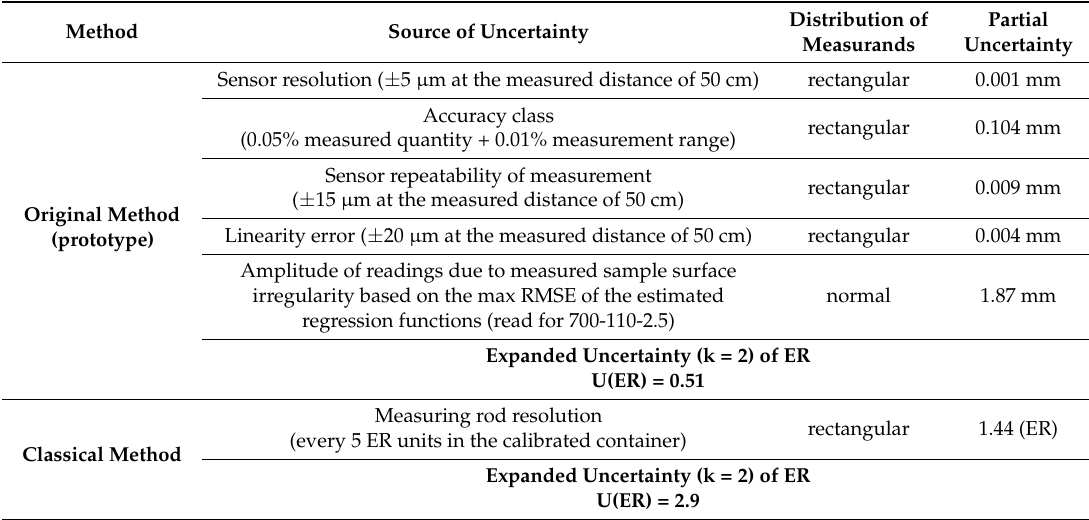
Table 3. Initial comparative evaluation of uncertainties of foamed bitumen ER measurement